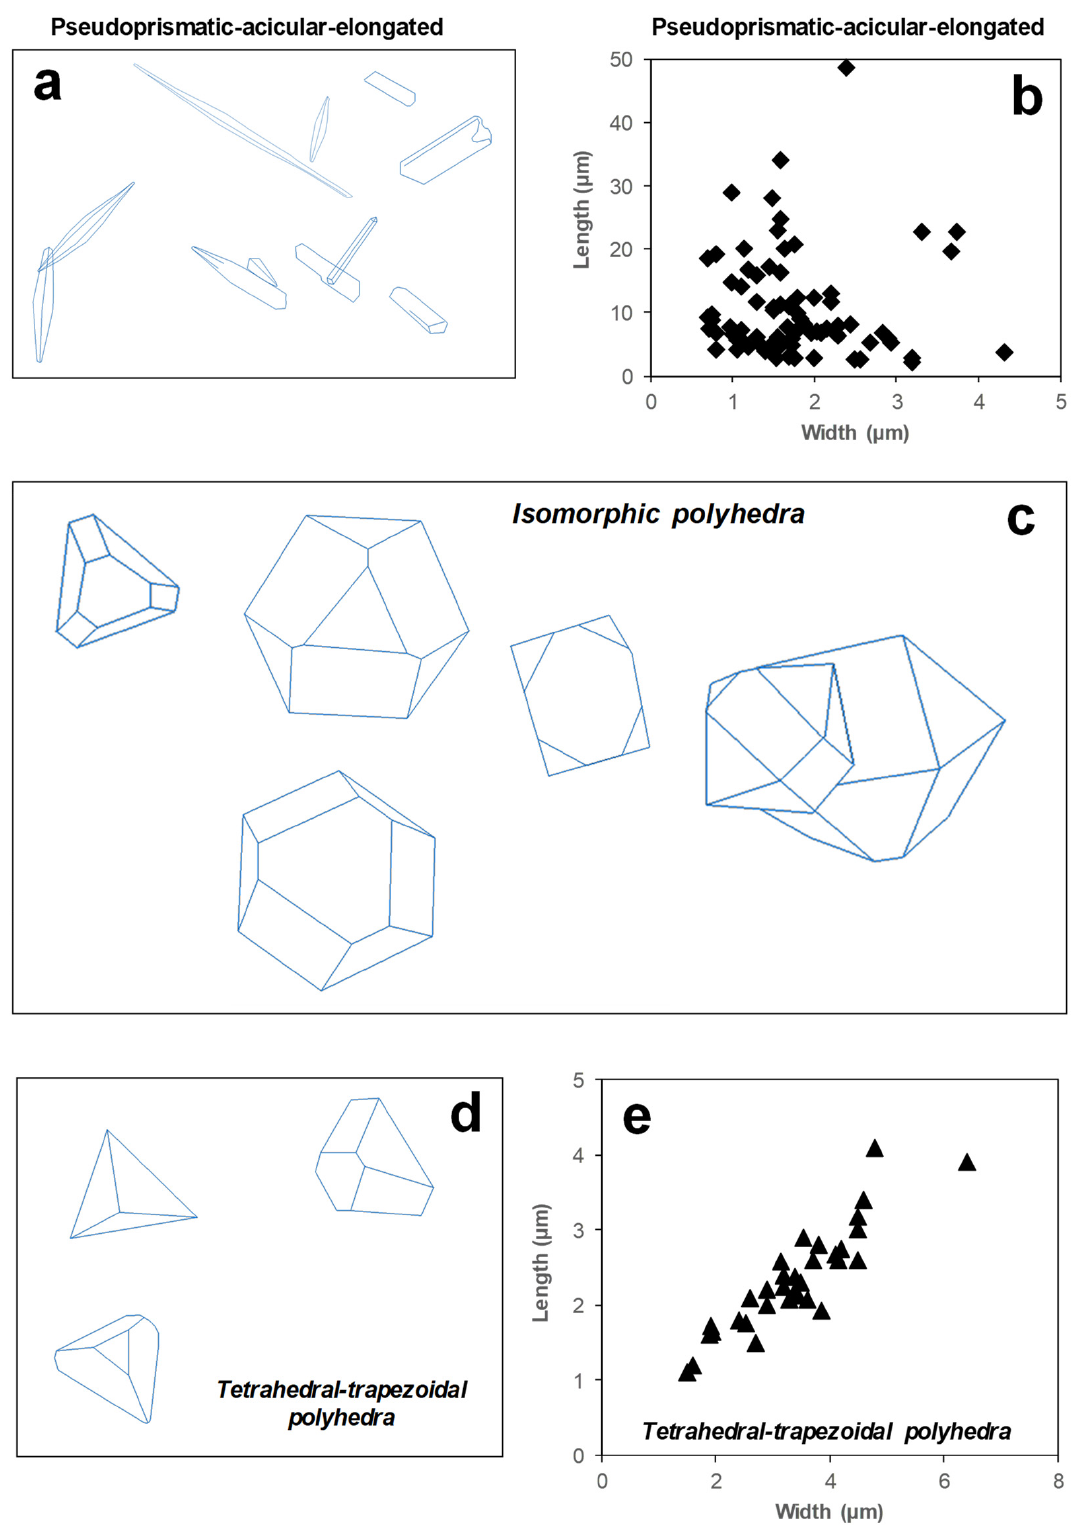
Figure 4. Geometric characteristics of different types of Cu[0] crystals formed in ascorbic acid reduc- tion experiments (10 mM AA, pH 3.95, 25 ◦ C) as deduced from the SEM pictures shown in Figure 3: ( a , b ) Pseudoprismatic-elongated-acicular crystals, ( c ) Isomorphic polyhedra, ( d , e ) Tetrahedral- trapezoidal polyhedra.